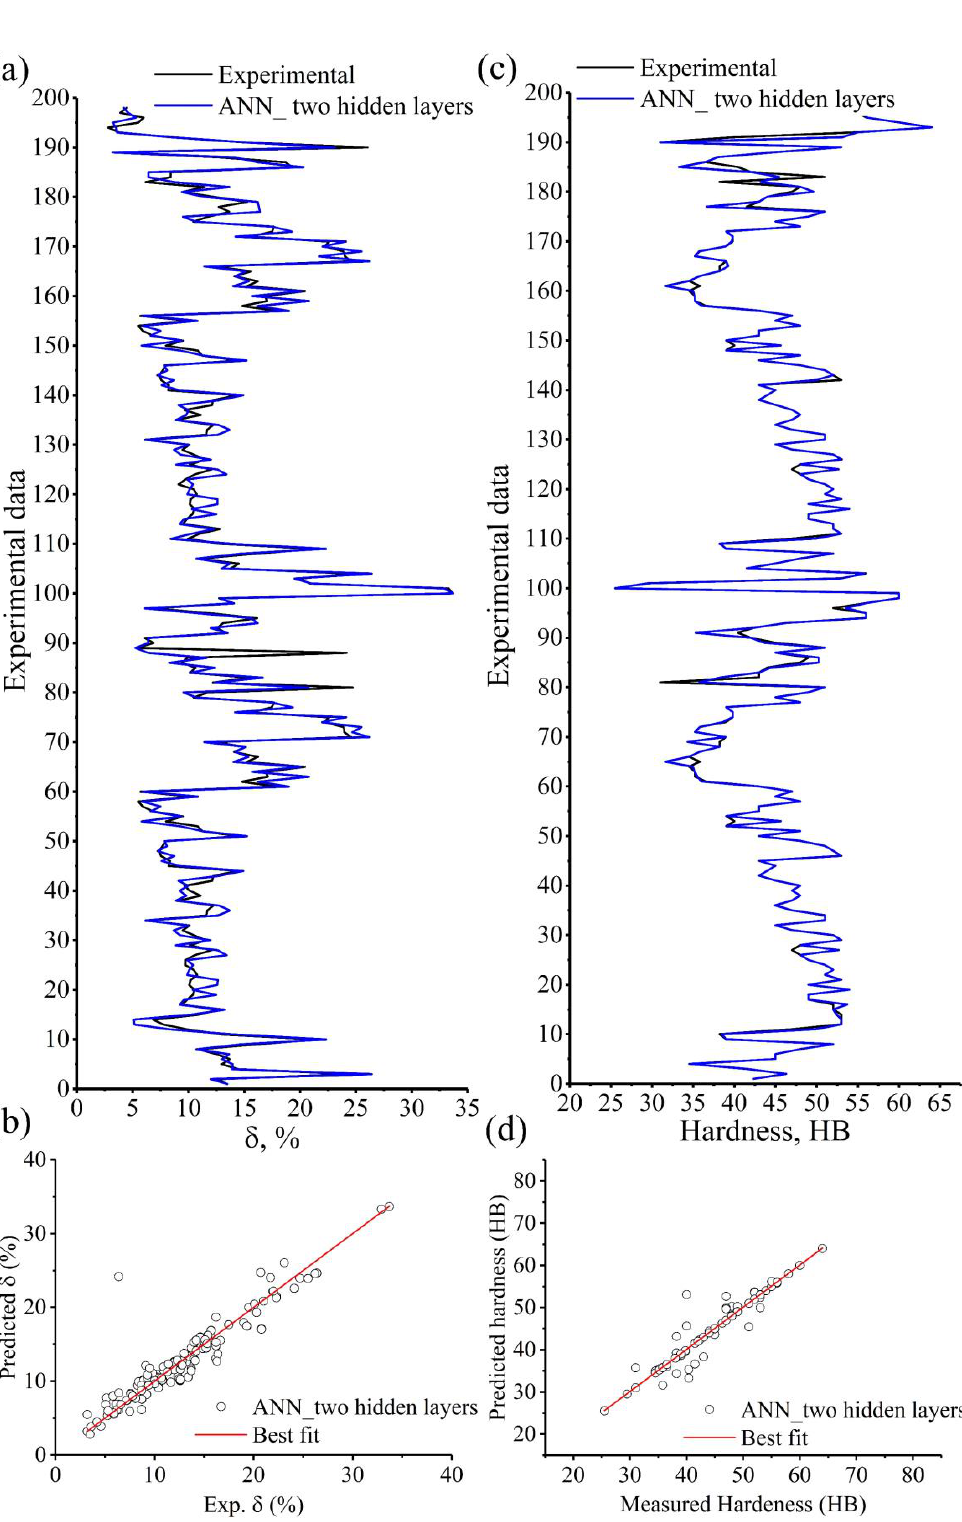
Figure 11. Experimental data compared to the predicted data of the ANN model with two hidden layers ( a , b ) elongation to failure, %, and ( c , d ) hardness, HB.